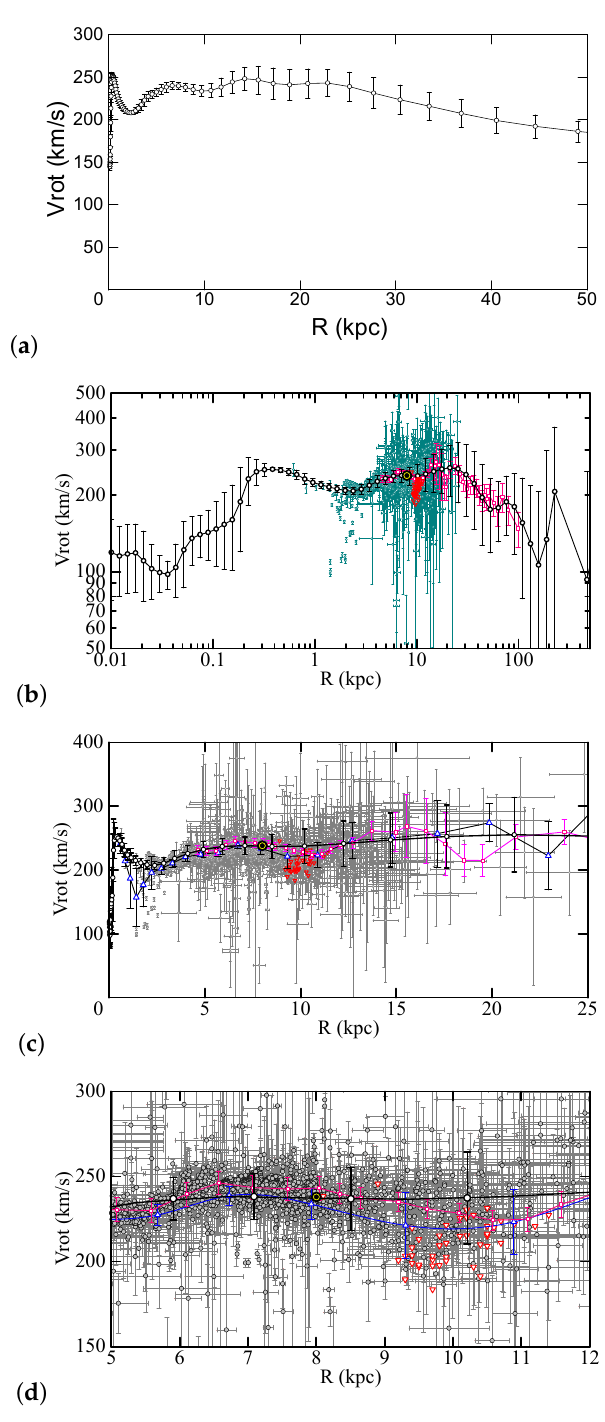
Figure 1. ( a ) Unified RC of the Milky Way used in this paper for the mass distribution obtained by averaging the RCs from references [1,29,36]. The bars are standard deviations within each Gaussian-averaging bin. The plotted values are listed in the tables in Appendix A. ( b ) Logarithmic RC of the Milky Way (circles), compared with those from the recent literature: Green circles with error bars are from the compilation by [27,28], and blue triangles are their running averages. Red triangles stand for data from [30] based on GAIA data. These two data are re-scaled to ( R 0 , V 0 ) = (8.0 kpc, 238 km s − 1 ). Pink rectangles are the RC by [29] without re-scaling. ( c ) Same, but in linear scale. ( d ) Same, but close up in the solar